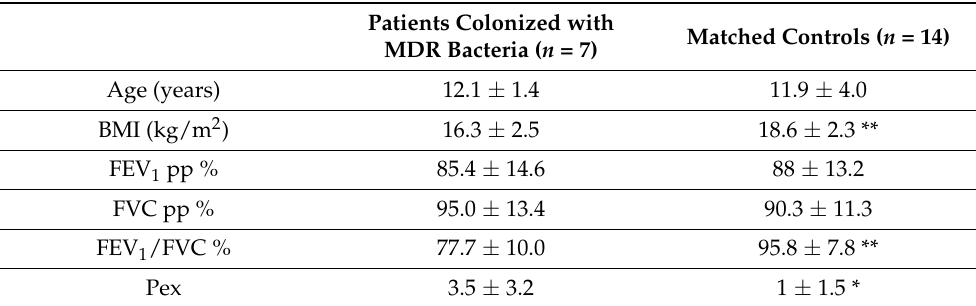
Table 3. Characteristics and pulmonary function tests in the year following the first detection of MDR bacteria in MDR group and in control